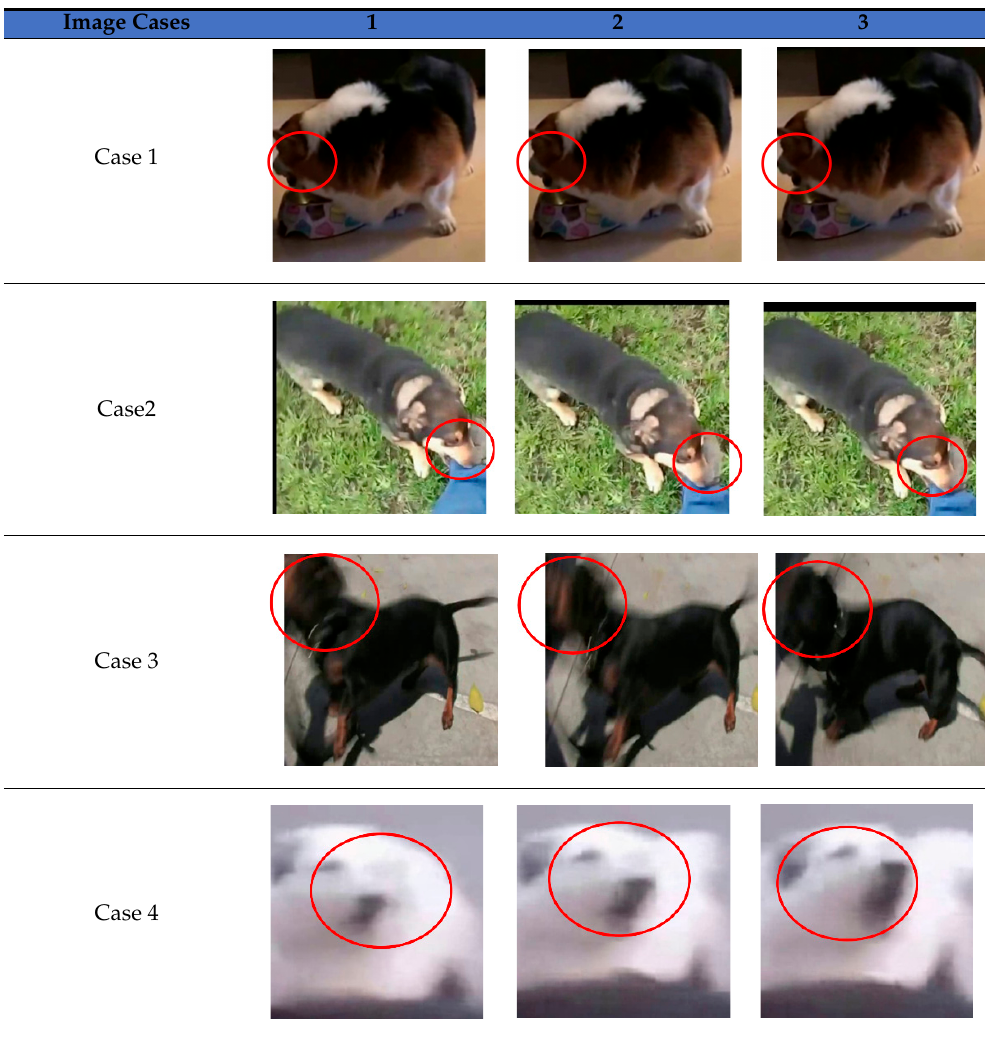
Table 16. Emotion recognition errors.